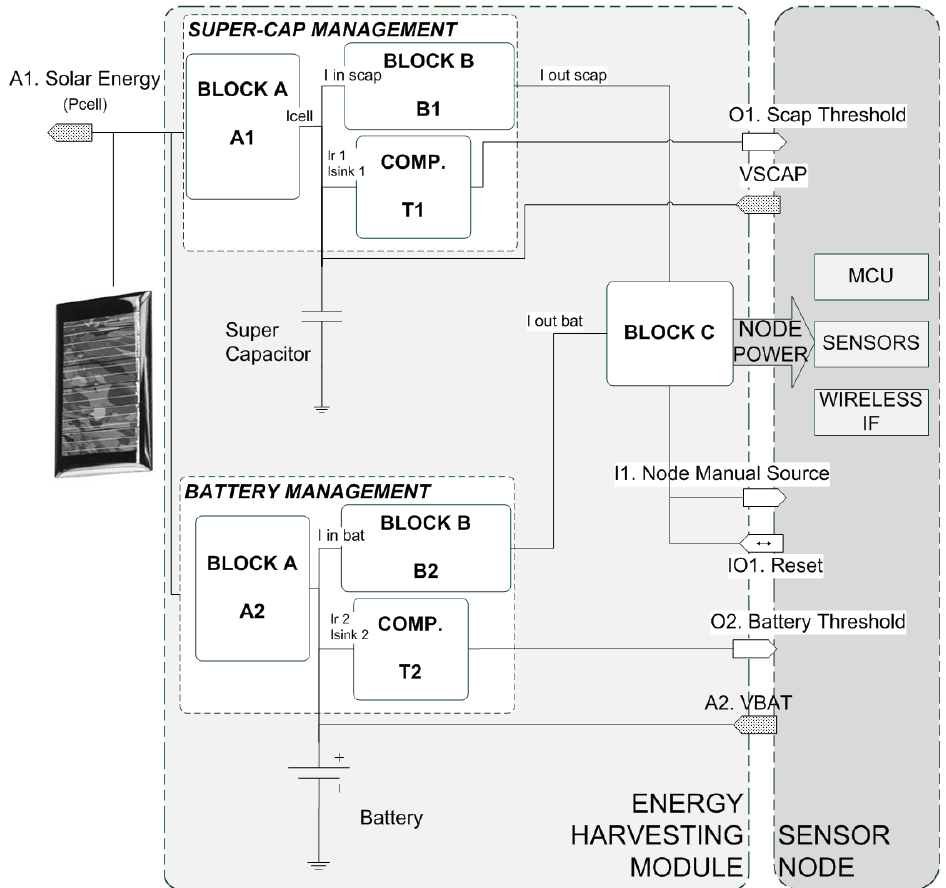
Figure 2. Generic energy harvesting circuit simplified block